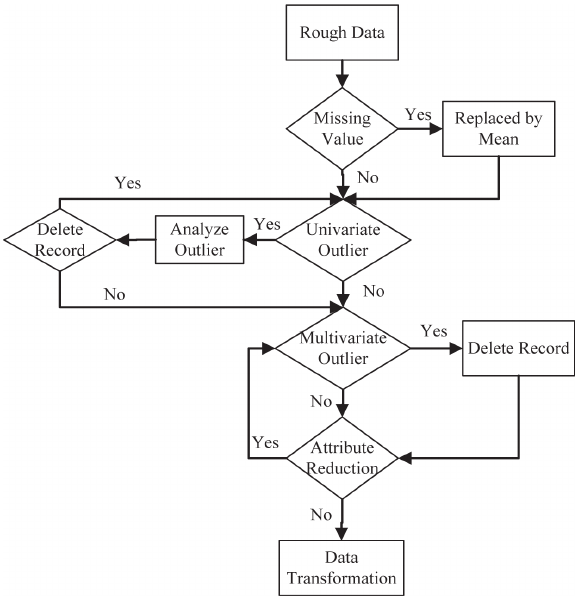
Fig. 6. Flowchart of data